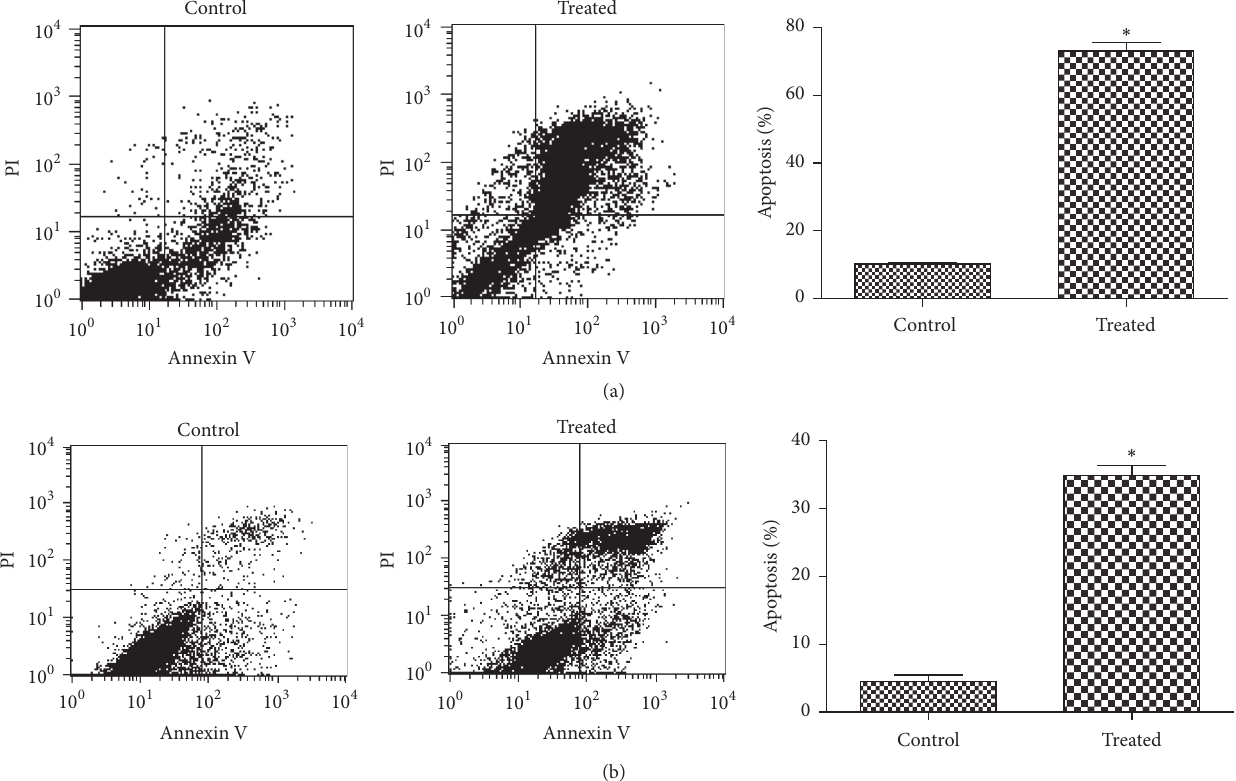
Figure 1: (a) A representative experiment of Annexin V-FITC/PI double-staining of GES-1 cells at 10h of treatment is shown. The proportion of Annexin V positive cells (AV+: apoptotic cells) in the control and treated groups were, respectively, 10.25% and 73.11%. (b) A representative experiment of Annexin V-FITC/PI double-staining of AGS cells at 10 h of treatment is shown. The proportion of Annexin V positive cells in the control and treated groups were, respectively, 4.54% and 34.9%. Data are presented as the mean ± SD of three independent experiments. ∗ When compared with the control, 𝑃 values < 0.05 were considered statistically